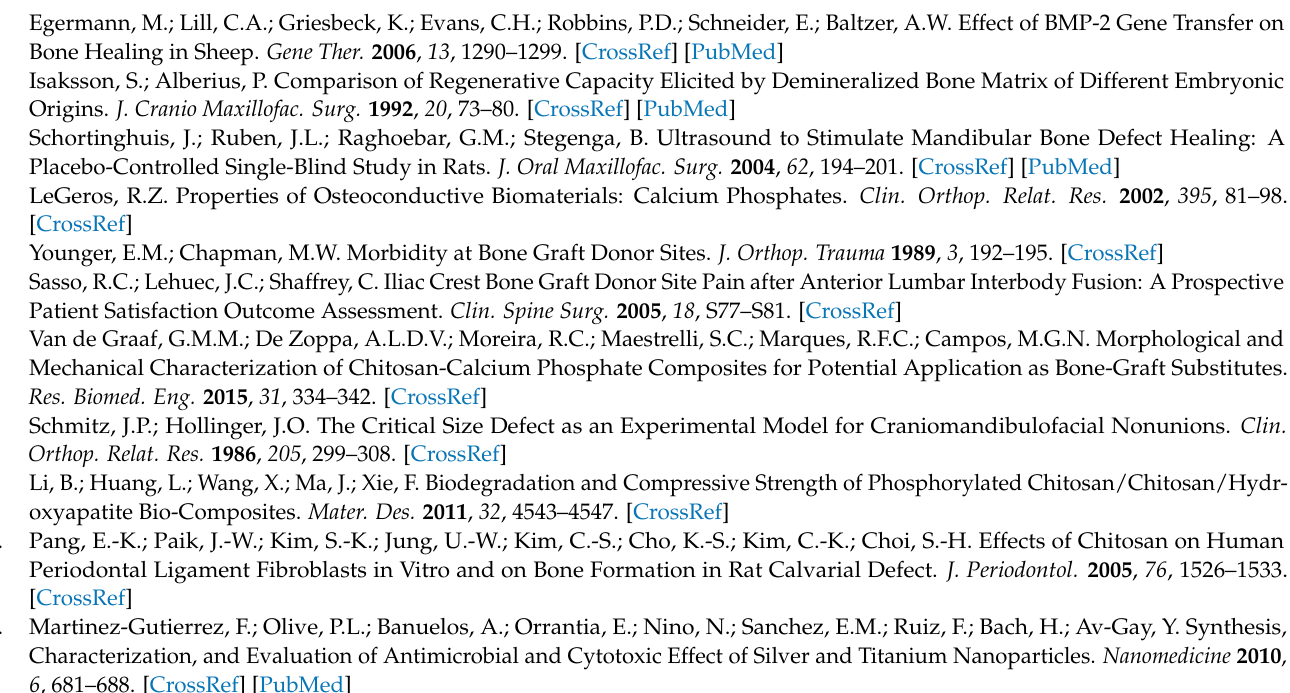
Figure S3: Characterization of the NPs used in this study by zeta potential; Figure S4: Representative images of organ histology; Table S1: Blood parameters were measured in animals of animals at 8 weeks expressed as a mean of n = 5; Table S2: Tissue levels of Ag expressed as mg/g wet tissue, n =